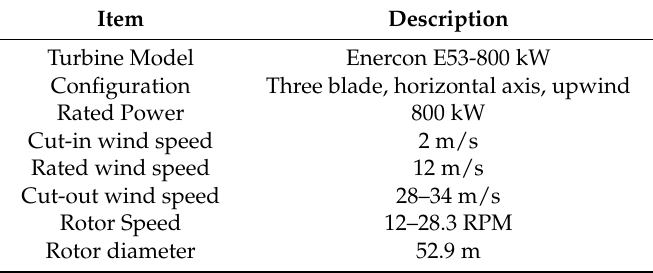
Table 3. Technical specifications of the selected wind